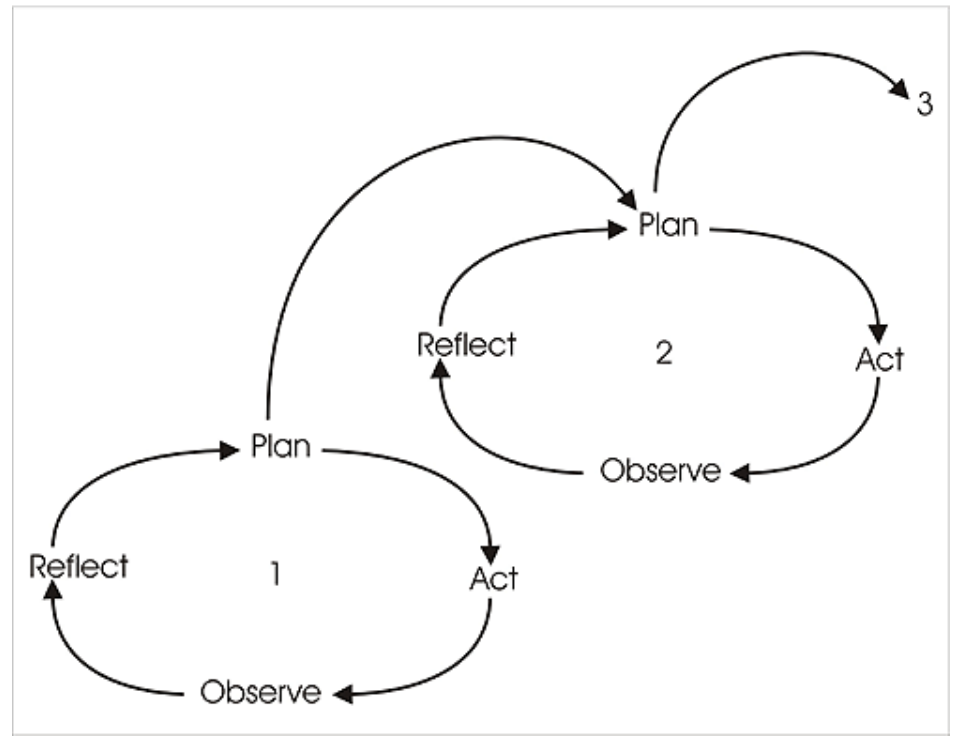
Figure 1 Action learning cycle as adapted from Engelbrecht et al .